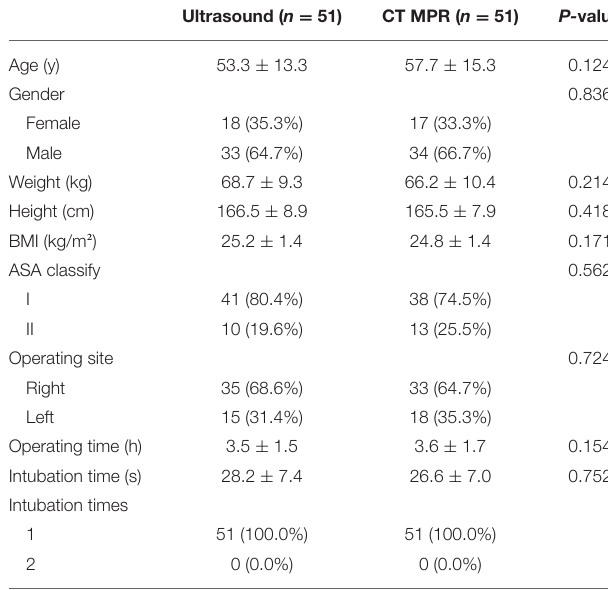
TABLE 3 | Comparison of observation indexes among the three groups. TABLE 4 | Comparison of general conditions of two groups.